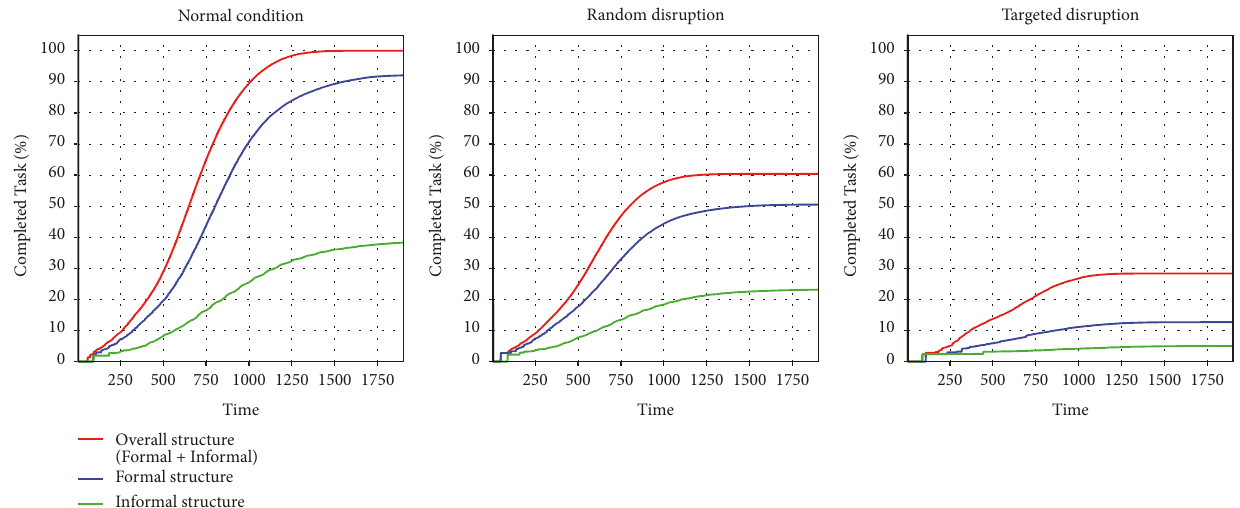
Figure 5: Average performance of sampled organisational structures in normal and disrupted